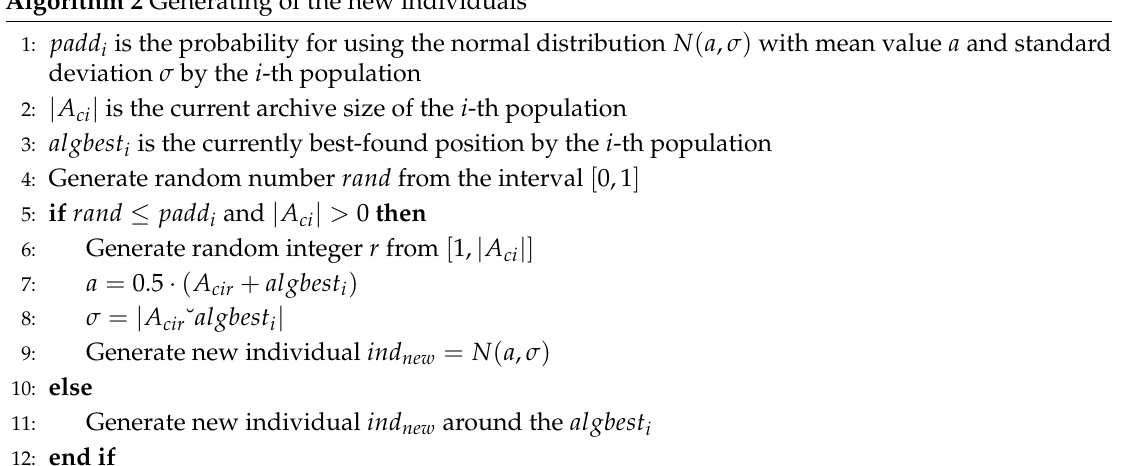
Algorithm 2 Generating of the new